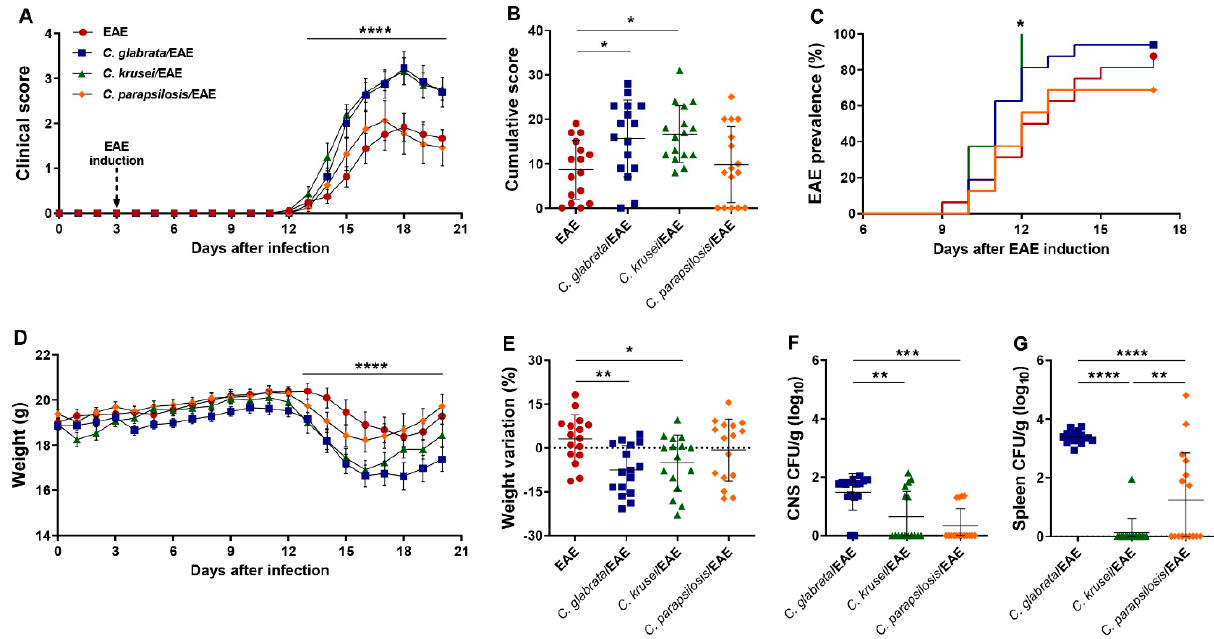
Figure 3. Effect of non- albicans Candida infection on EAE development. Female C57BL/6 mice were infected with 5 × 10 6 viable yeasts of C. glabrata , C. krusei , or C. parapsilosis three days before EAE induction and evaluated for the daily clinical score ( A ), cumulative score ( B ), the percentage of disease prevalence ( C ), daily body weight ( D ), and weight variation percentage considering the initial (day 0) and the final weight (day 20) ( E ). Fungal load in CNS ( F ) and spleen ( G ) samples were evaluated on the 20th day after infection. The results are expressed as mean ± SD from four independent experiments (n = 16/group), and * p < 0.05, ** p < 0.01, *** p < 0.001, and **** p < 0.0001.